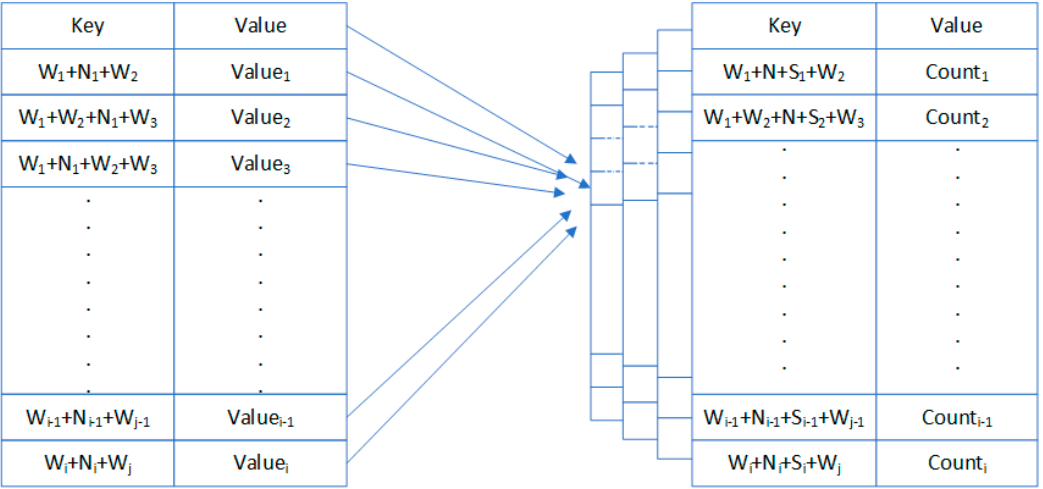
Figure 1. Diagram of a nested hash